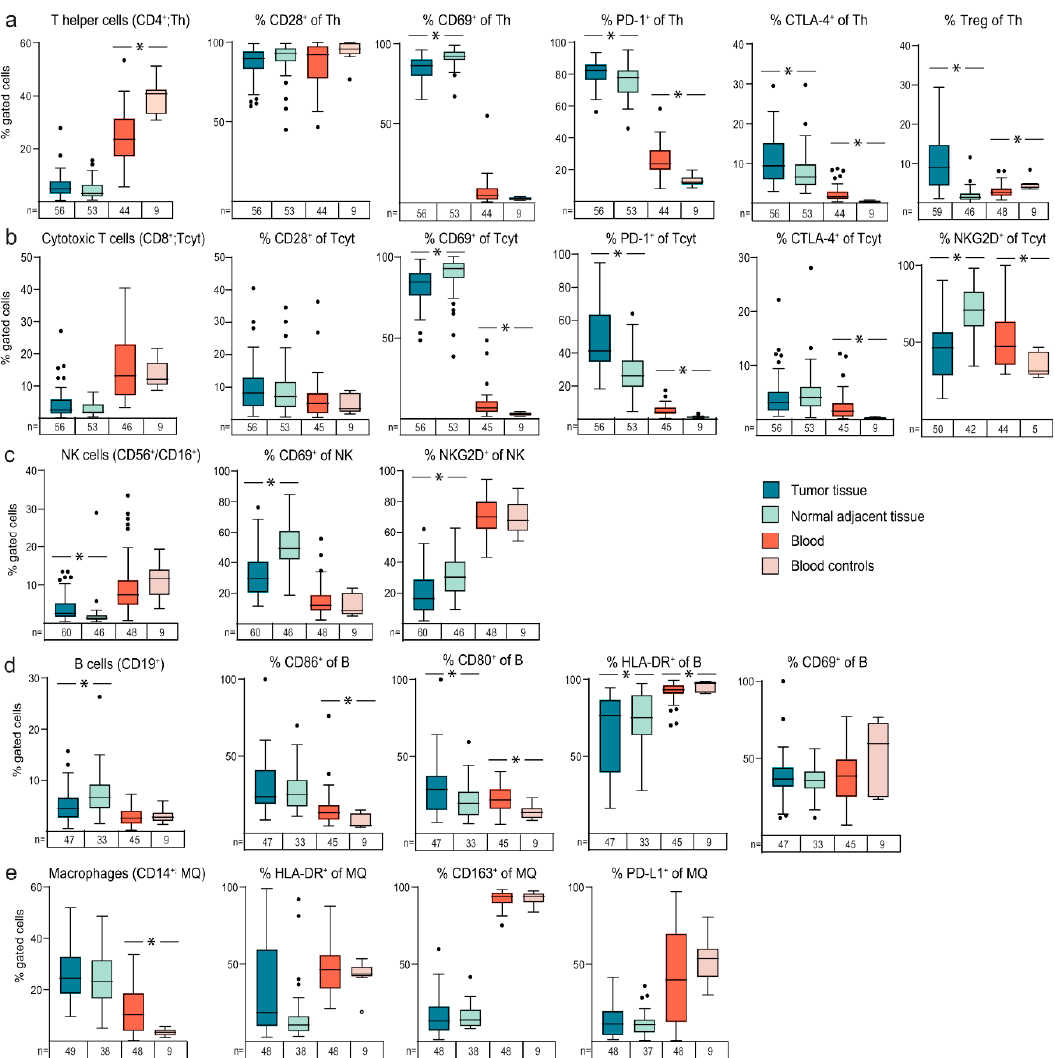
Figure 1. Distribution of immune profiles in tissue and blood of patients diagnosed with colorectal cancer (CRC). Box and whiskers plots illustrating percentages of subsets of ( a ) T helper cells, ( b ) cytotoxic T cells, ( c ) NK cells, ( d ) B cells and ( e ) macrophages, in isolated mononuclear immune cells from tumour tissue compared to adjacent normal tissues, and blood samples from CRC patients compared to controls, as indicated. Horizontal lines indicate median values. * indicates p -values < 0.05.